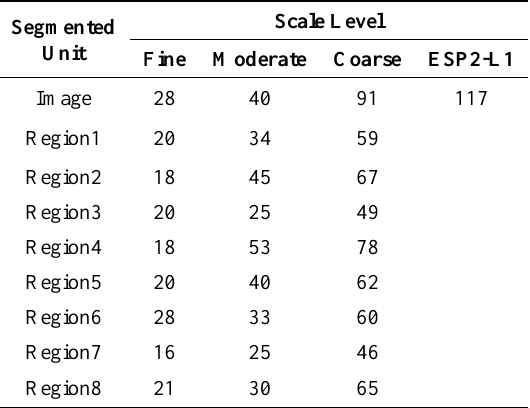
Table 1. Estimated scale parameters for whole image and extracted regions at three